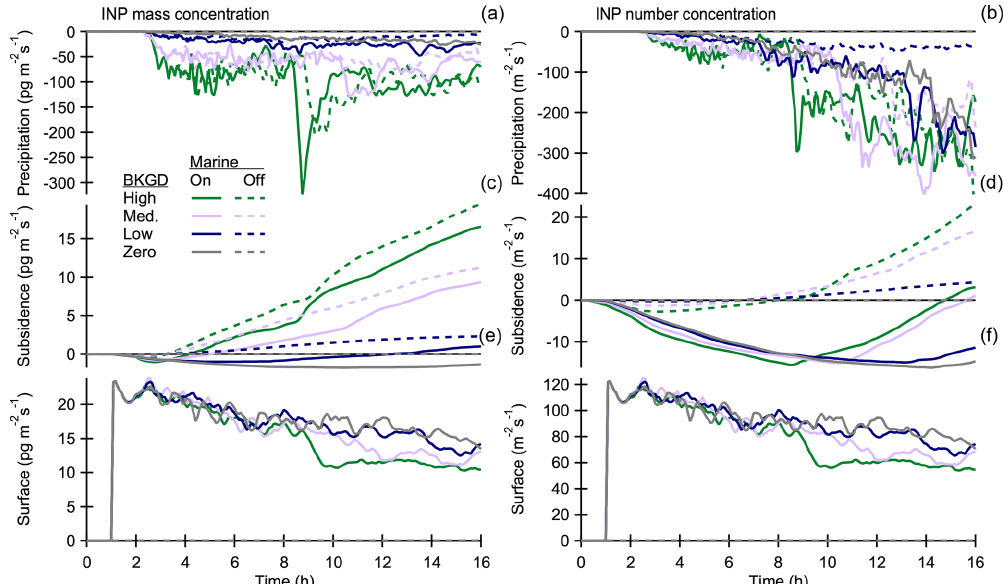
Figure 3. The three mechanisms (precipitation, subsidence and surface emissions) affecting on INP mass (a, c, e) and number (a, d, f) concentrations. Simulations are initialized with different background INP concentrations and marine INP emissions are switched on (solid lines) or off (dashed lines). The effects of surface emissions and subsidence on INP number concentration are calculated for particles larger than 159nm in dry diameter.